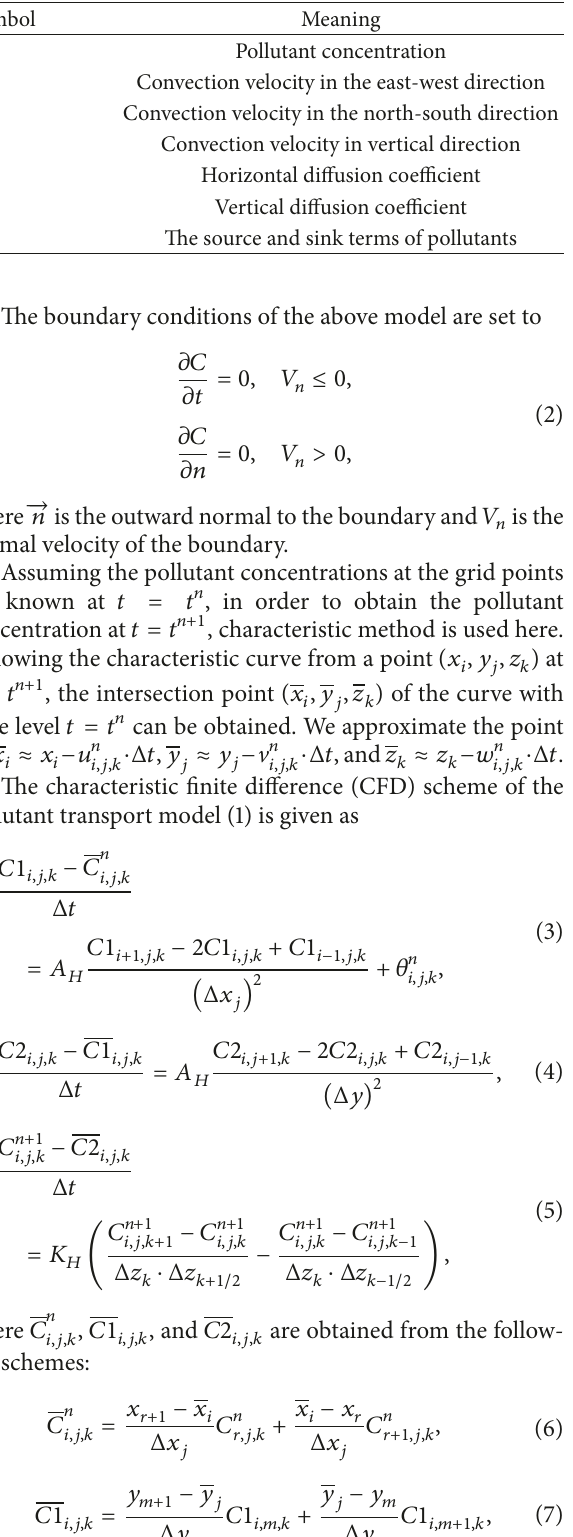
Table 1: The symbols in the pollutant transport model